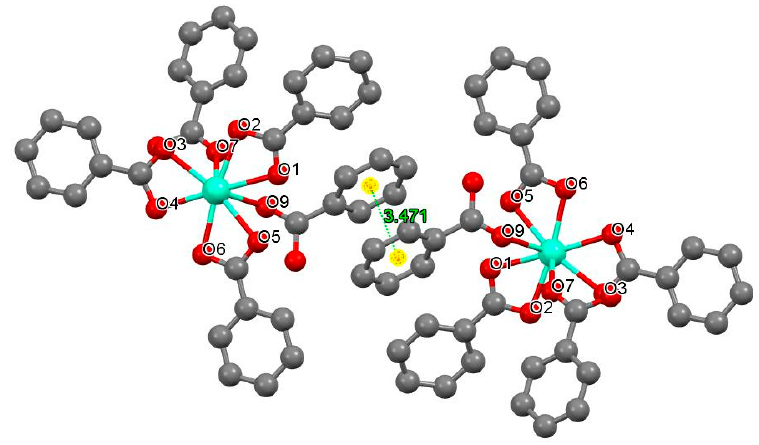
Figure 8. Crystal packing of complex 2 , showing π ··· π interactions.